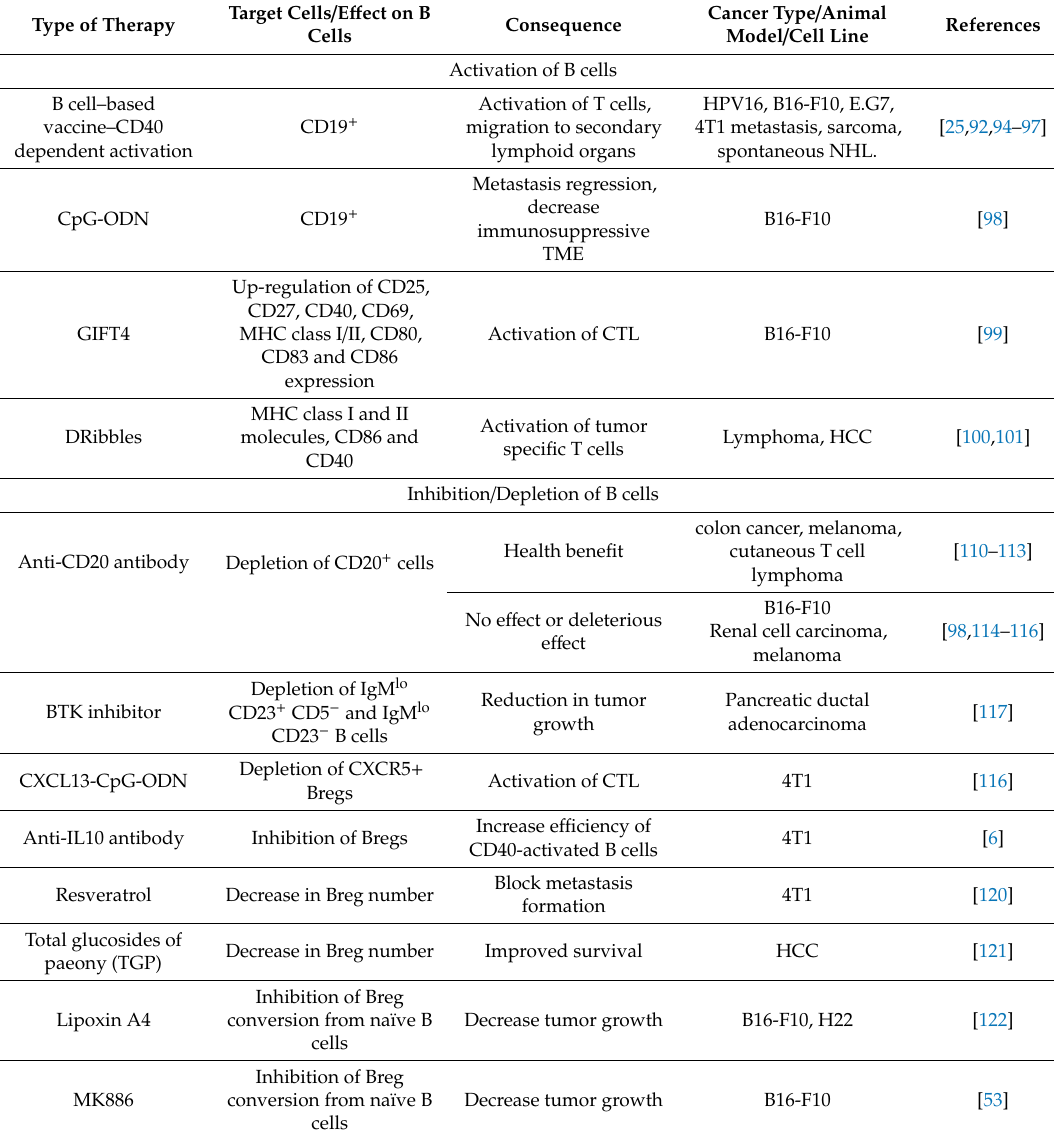
Table 3. The di ff erent anti-cancer therapies targeting B cells, either through their activation or on the contrary through their depletion / inhibition are